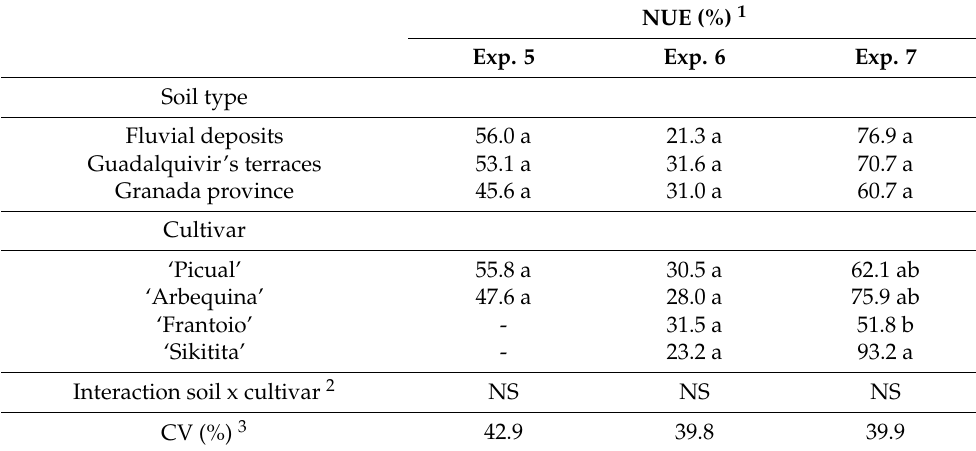
Table 6. Nitrogen uptake efficiency of olive cultivars growing in different